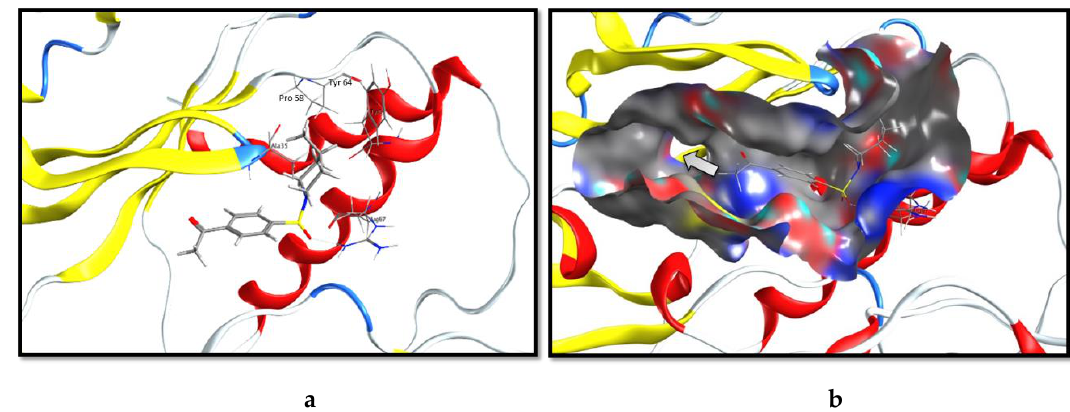
Figure 2. The virtual binding mode of compound 3 at the extracellular signal-regulated kinase 1 (ERK1) kinase domain. ( a ) The molecular interactions of compound 3 with amino acid residues at the binding pocket. ( b ) The surface representation of the binding mode of compound 3 , depicting the rational of the molecular extension (indicated by the arrow).